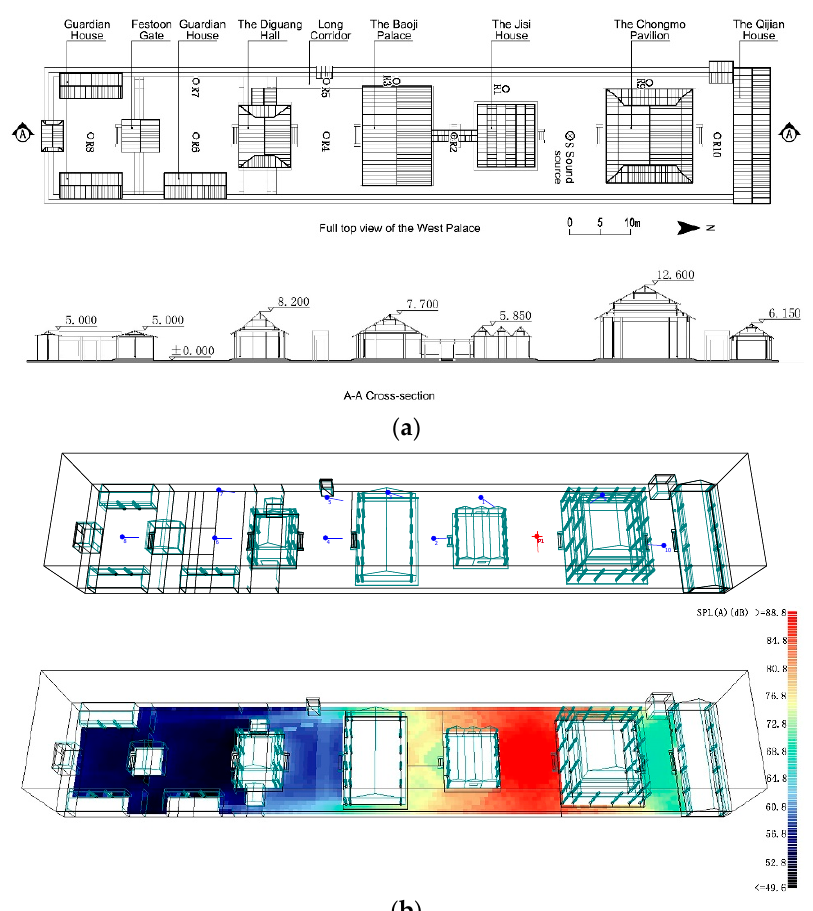
Figure 3. Survey mapping and sound-field simulation diagram of the West Palace. ( a ) The top view and cross-sectional view of the West Palace. ( b ) The acoustic model diagram and sound pressure level (SPL) distribution diagram of the West Palace.